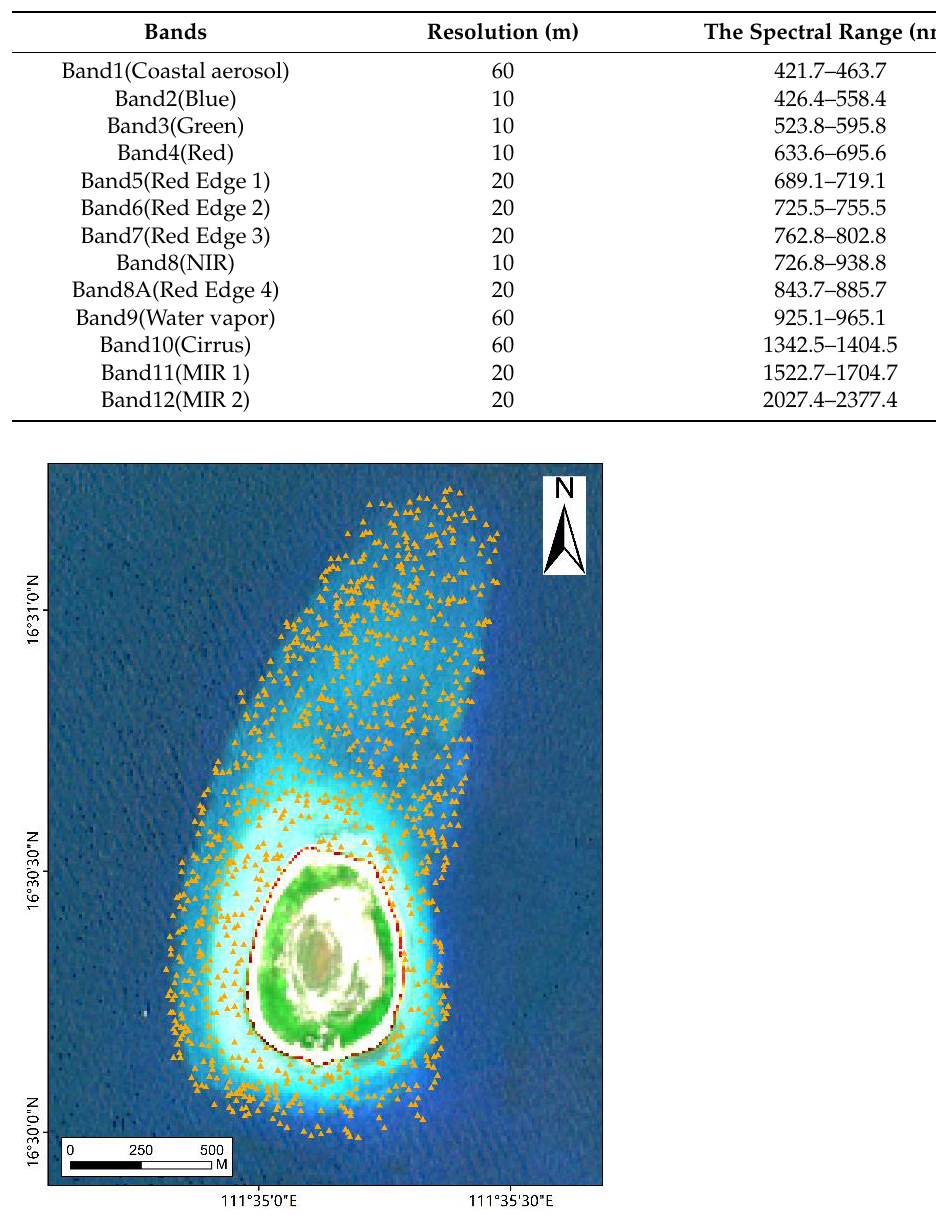
Table 1. Sentinel-2A band information.